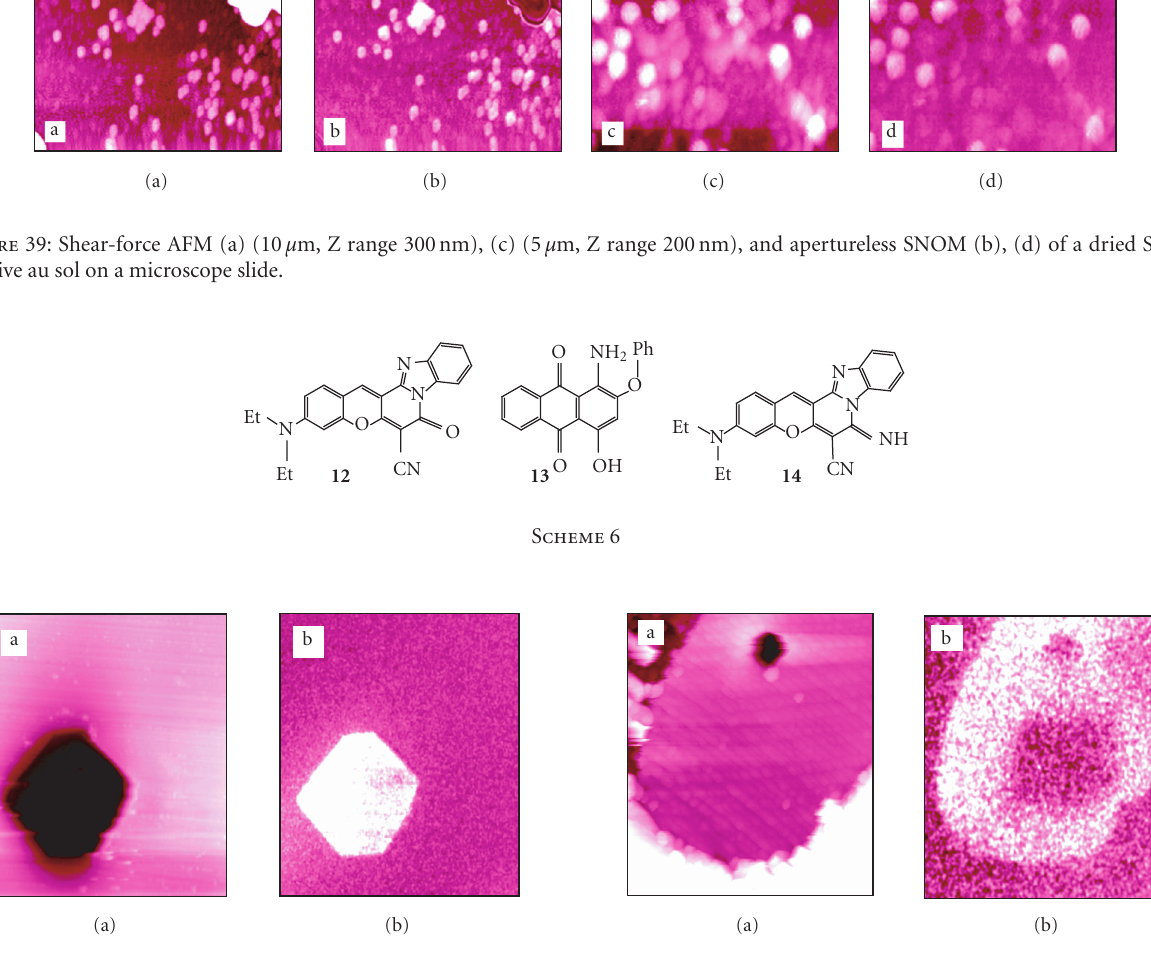
Figure 42: Simultaneous shear-force AFM (a) (20 μ m, Z range 5 μ m) and fluorescence SNOM (b) of a microtome cut surface of an evenly dyed polyester fiber (dye 13 ) in Technovit 7100 after 10min illuminated scanning in a 5 × 5 μm 2 area of the dyed fiber showing local fluorescence